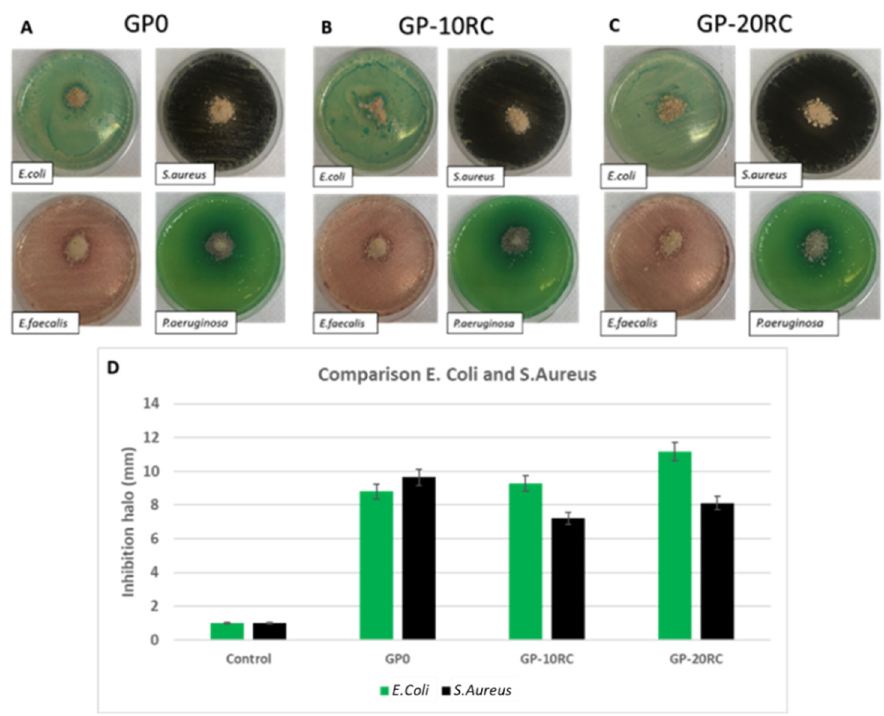
Figure 7. Inhibition halo of E. coli , S. aureus , E. faecalis , and P. aeruginosa for samples: ( A ) GP0; ( B ) GP-10RC; and ( C ) GP-20RC. ( D ) Comparison of the inhibition halo of E. coli and S. aureus for the three